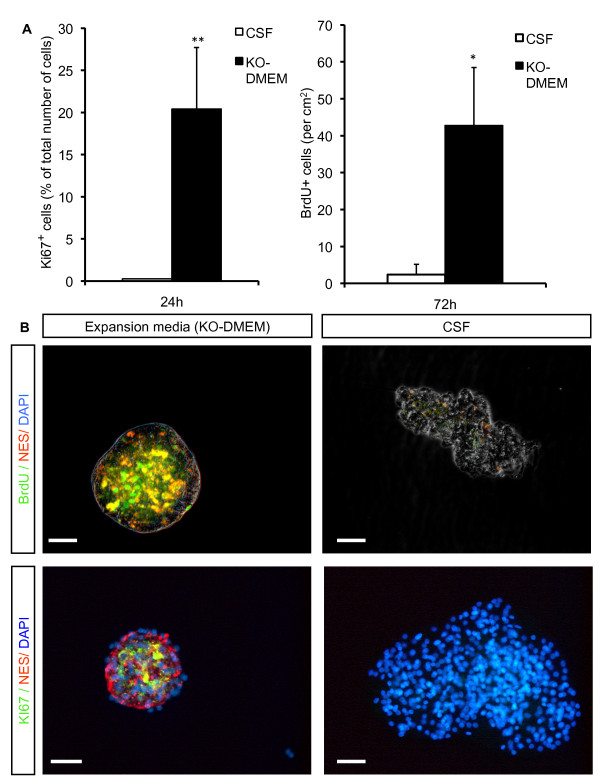
Investigation of cell proliferation in adult human NSCs during expansion. The portion of NSCs with potential to self renewal expanded in culture medium supplemented with EGF and FGF-2 or CSF without additional growth factors was determined 24 and 72 hours after medium change. A, Percentage of Ki67+ cells after 24 h, number of BrdU+ cells per cm2 after 72 h. Values represent the mean ± S.E.M from at least three independent experiments. *indicates P < 0.05 and ** P < 0.01 compared to each corresponding value in CSF. B, Representative microphotographs demonstrating the influence of CSF on proliferation markers in NSCs. For immunostainings cells were stained with anti-BrdU (upper panel) and anti-Ki67 (lower panel) and anti-Nestin (upper and lower panel). Nuclei were counterstained with DAPI (lower panel). Altered morphology of neurospheres with CSF treatment (right panel) is most likely due to the beginning differentiation process. Scale bar = 50 μm.